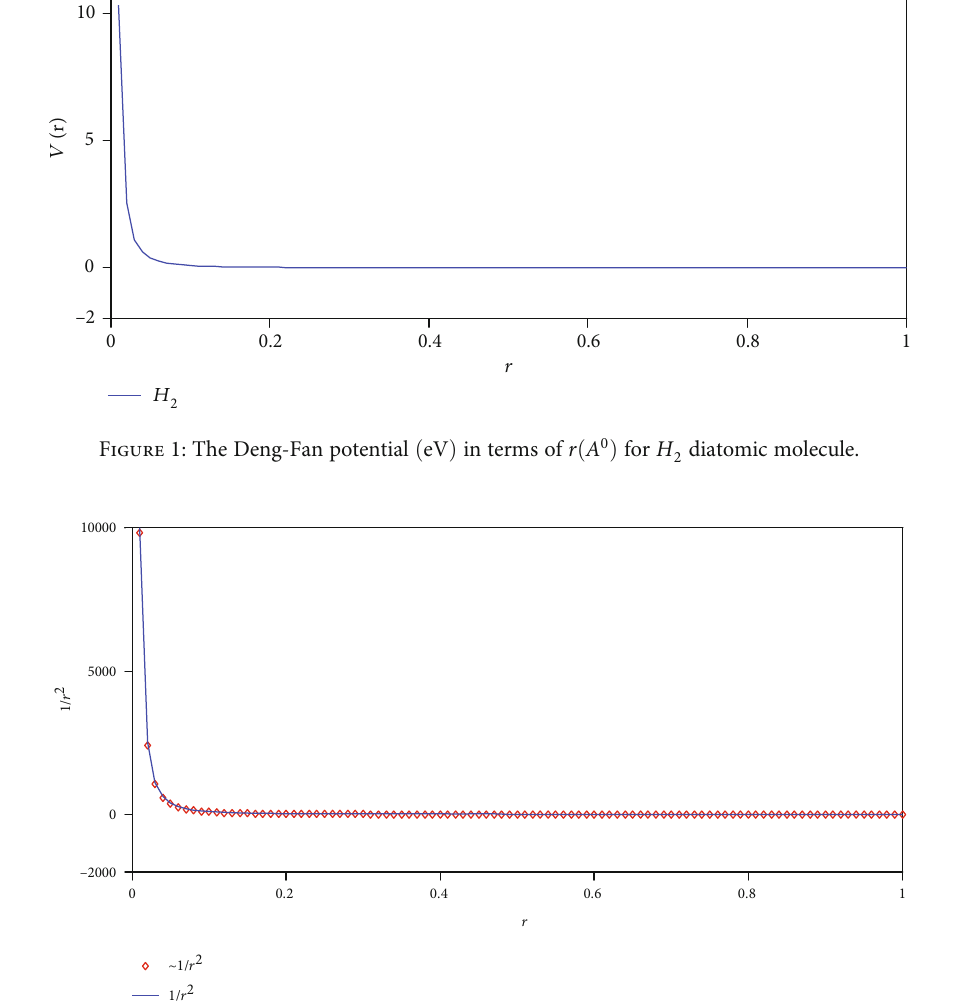
Figure 2: Comparision between 1/ r 2 of the Deng-Fan potential and the approximation scheme as function of r for H